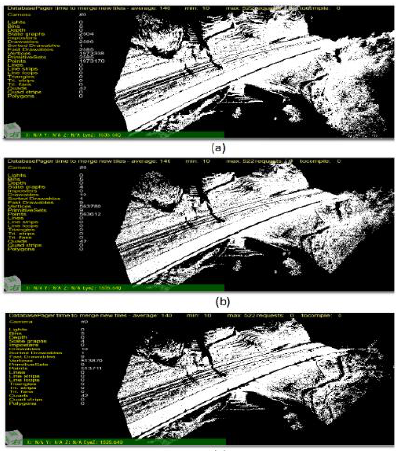
Figure 5 Mesh filtering to reduce invalid points - highway areas. Where, (a)The original 1.97 million points. (b) 0.1m cell size, getting 0.56 million lowest points. (c) 0.51 million ground points are